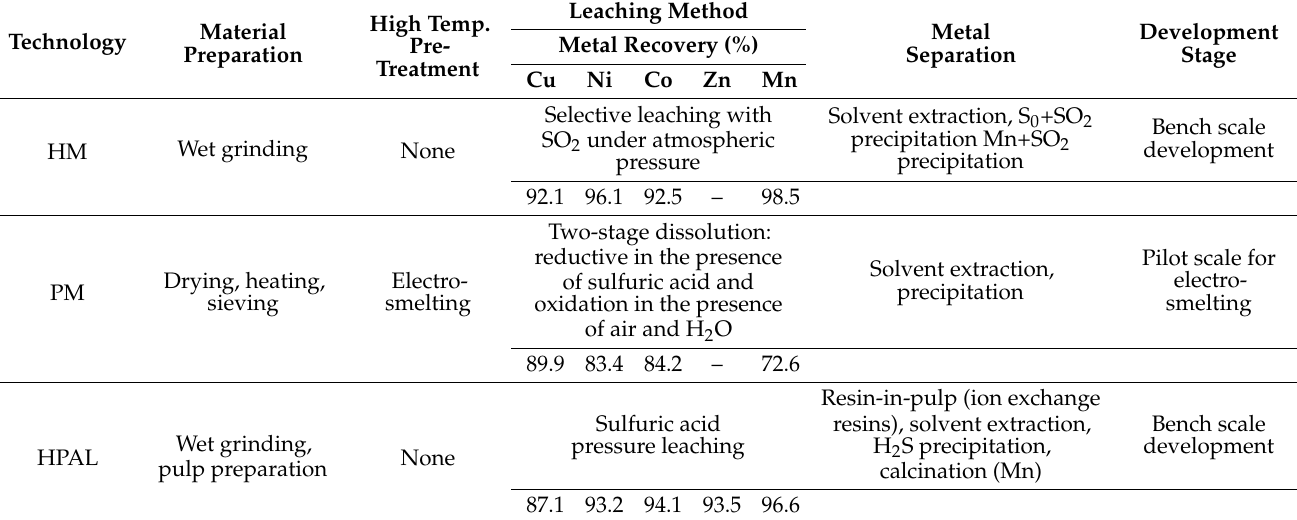
Table 3. Comparison of the three processing technologies optimized by IOM